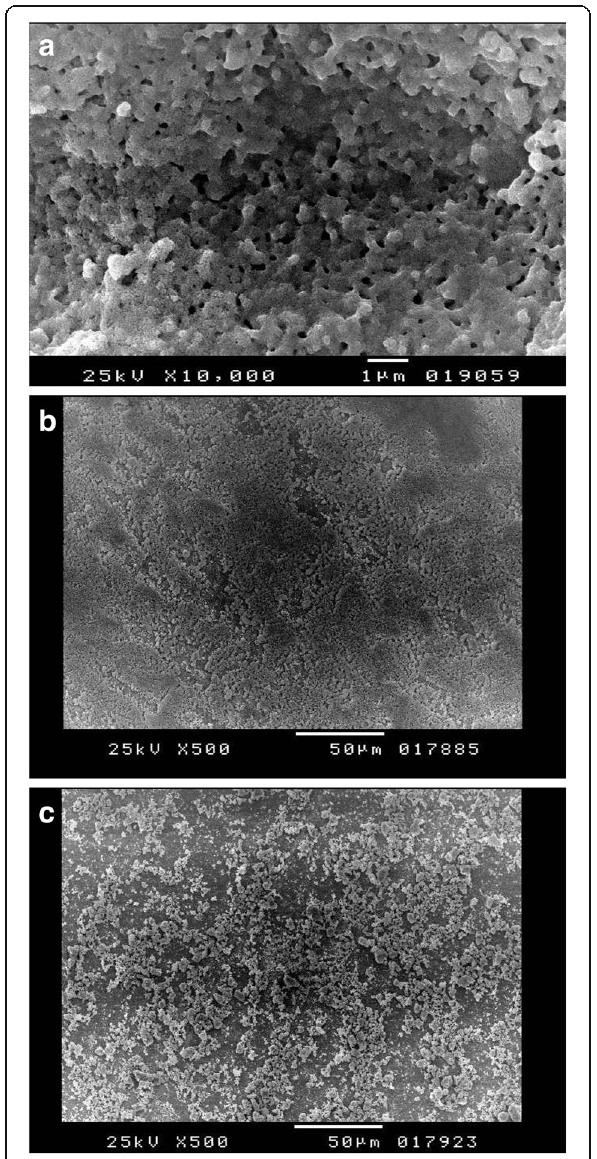
Fig. 2 a SEM image, ×10,000, demonstrating the characteristic porous surface of selective infiltration etching surface of zirconia. b SEM image, ×500, demonstrating deposition of PRP coat and complete filling of the porous surface. c SEM image, ×500, demonstrating filling of the porous surface with particles of HA